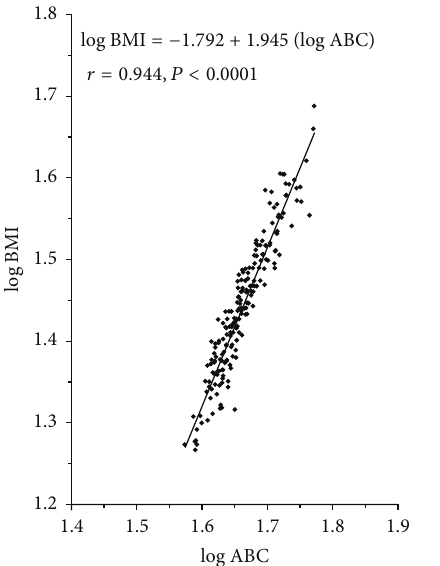
Figure 1: Linear regression of log ABC (average body circumfer- ence) on log BMI in the entire study population.